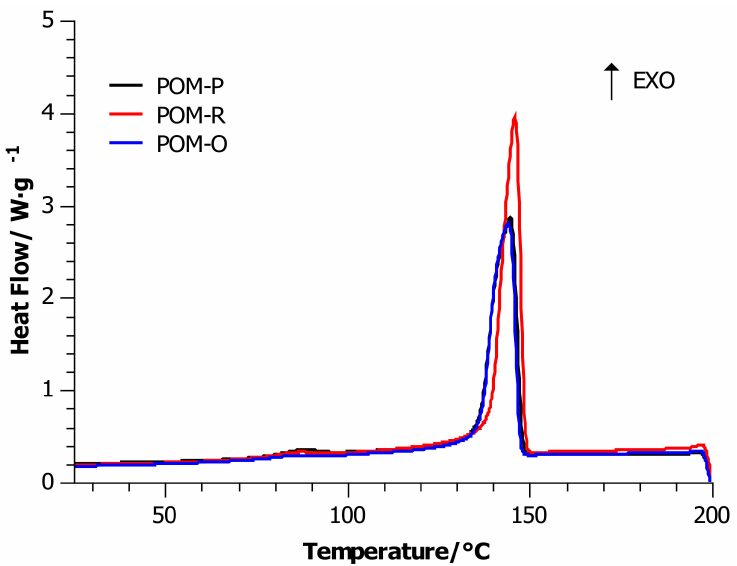
Figure 2. DSC cooling curves for POM-P, POM-R, and POM-O